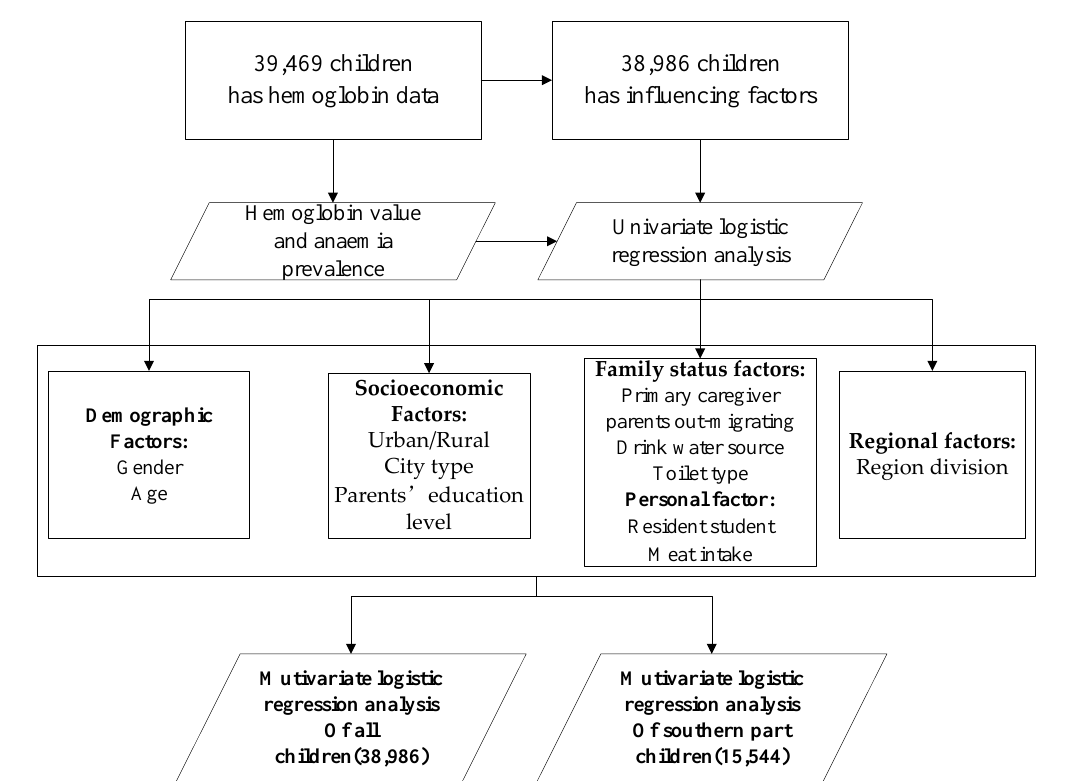
Figure 1. Flowchart of study